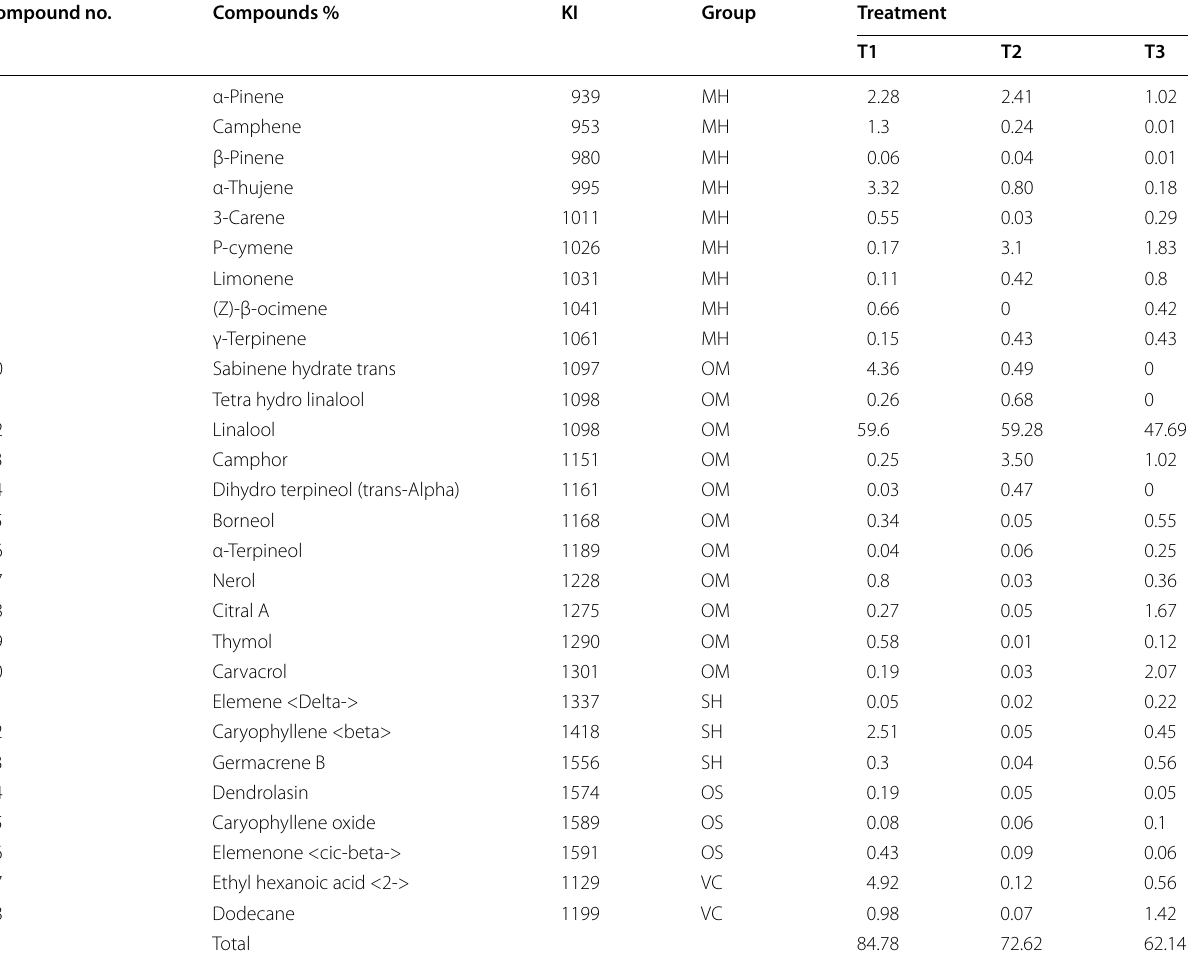
Table 2 Percentage variation of the essential oil constituents of the seeds of coriander plant under different storage conditions for 1